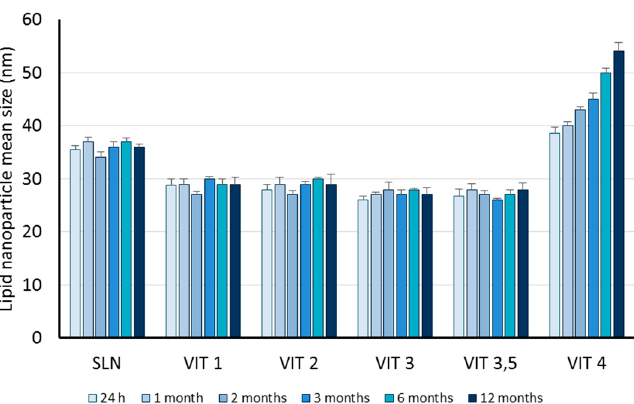
Figure 1. Mean sizes of unloaded solid lipid nanoparticles (SLN) and nanostructured lipid carriers (NLC) during storage at room temperature for 12 months.